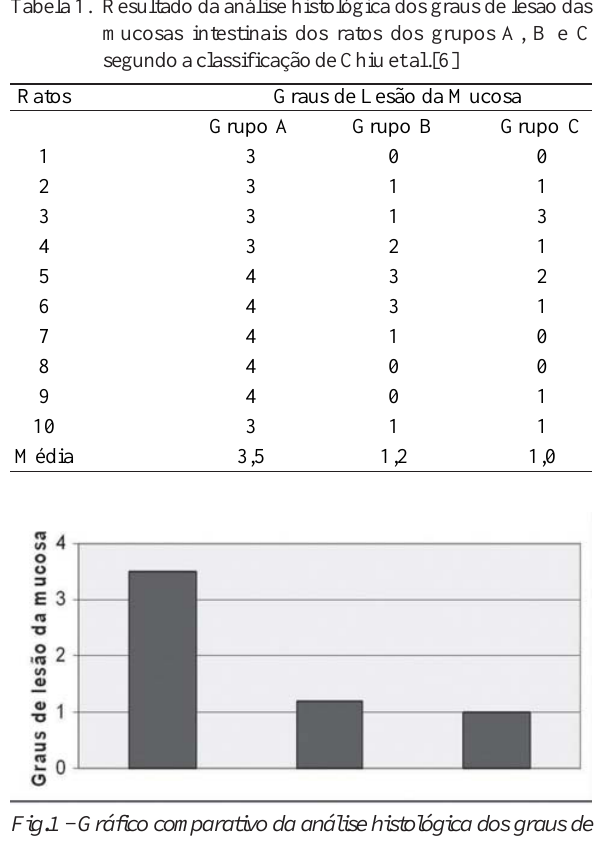
Tabela 1. Resultado da análise histológica dos graus de lesão das